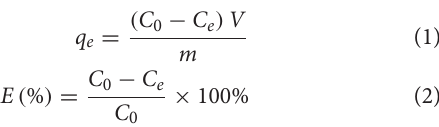
Frontiers in Materials |